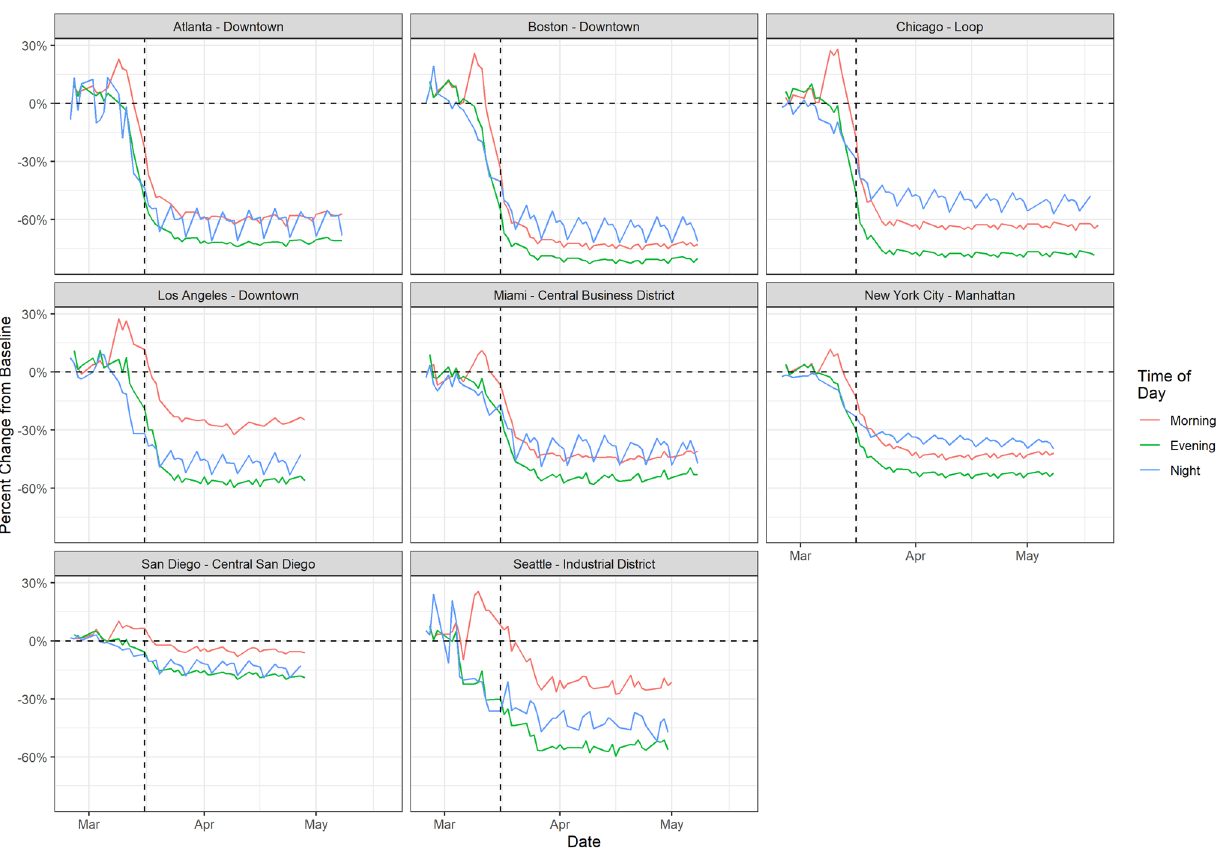
Figure 1. Percent change in population of weekday Facebook users in urban centers, divided into times of day. The vertical black line is March 16th, 2020, the day that the national suggested restriction on size of gatherings and non-essential travel was implemented. In all locations, there is a noted increase in the “Morning” population of Facebook users compared to the average number of Facebook users in that location during that day of the week and time of the day over the preceding 90